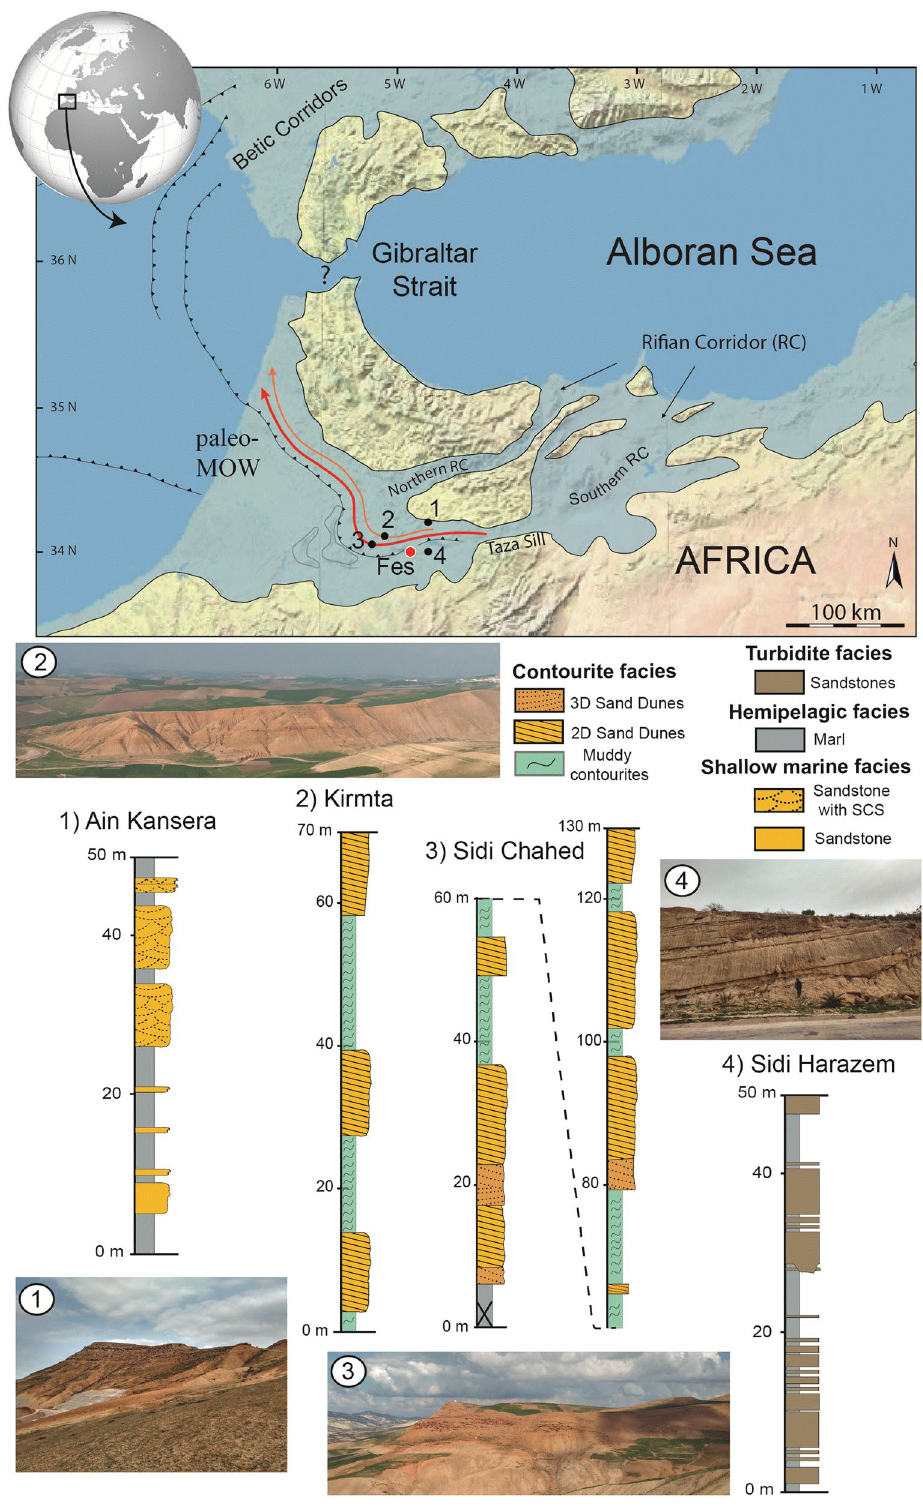
Figure 1. Palaeogeographic reconstruction of the late Miocene western Mediterranean with the location of the studied outcrops; red (lower) and orange (upper) arrows show palaeo-Mediterranean Outflow Water (palaeo- MOW) branches (modified from de Weger et al. 2 ). Below, schematic sedimentary logs of the studied outcrops. Map created with Adobe Illustrator, version 22.1.0 (https ://www.adobe .com/produ cts/illus trato